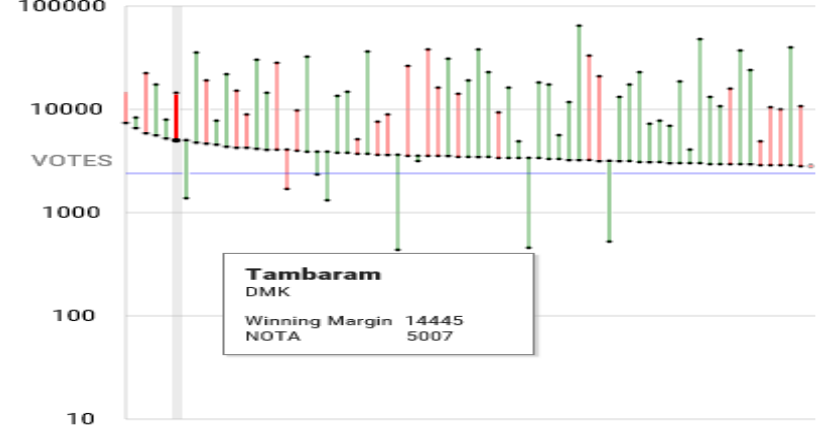
Figure 8 is an interactive line charts presented in non-aligned fashion. Statistics for winning margin and one of the parameters as mentioned above for each constituency are represented by two bubbles. These bubbles represent votes which number typically in several thousands, hence they are plotted on a logarithmic scale by transformation of data. The logarithmic scale was used due to the varied values of the victory margins. Showing that on a linear scale would result in an extremely tall graphic. Also, in this case, inter-constituency comparison was not the focal point, instead what the graphic aimed to aid was intra-constituency comparison of victory margin versus party votes. Hence, using the logarithmic scale does not serve so much to represent the absolute numbers as to contain the graphic within a reasonable size. Figure 9: Enlarged View of Winning Margins and Effect of NOTA